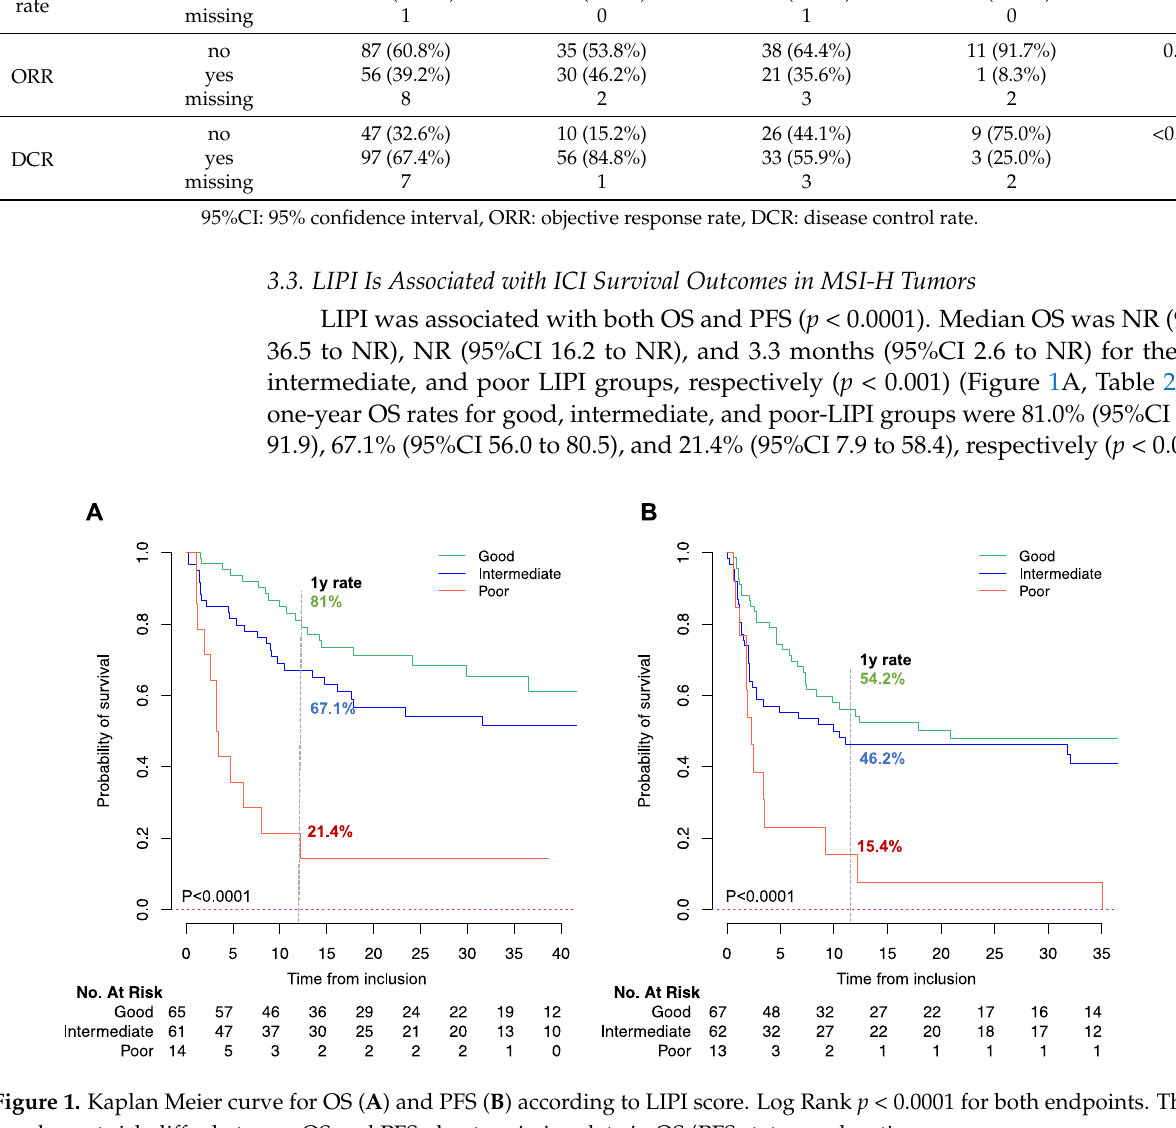
Table 3. Multivariate Cox model analysis for OS and PFS in the population.